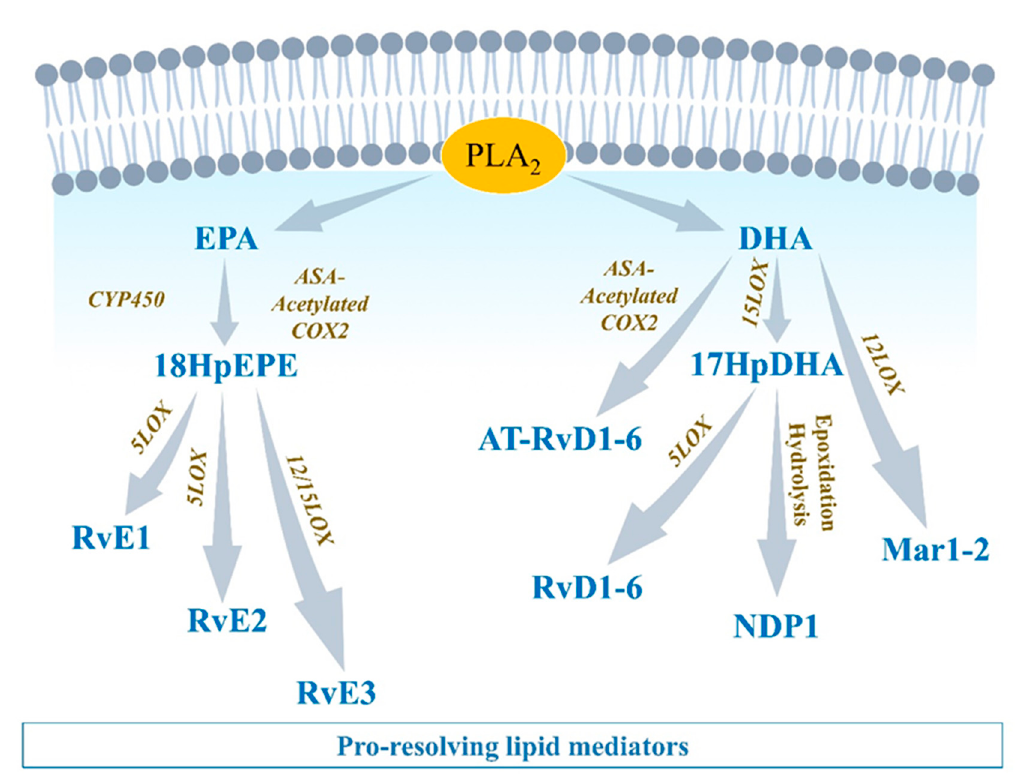
Figure 3. Eicosapentaenoic acid-, and docosahexaenoic acid-derived lipid mediators Eicosapentaenoic acid (EPA) and docosahexaenoic acid (DHA) compete with AA in interacting with COX1/2, 5LOX, 12LOX, and 15LOX. Lipids produced from EPA and DHA metabolism include E-series resolvins (RvE1-3) and D-series resolvins (RvD1-6), respectively, which are involved in pro-resolution mechanisms.